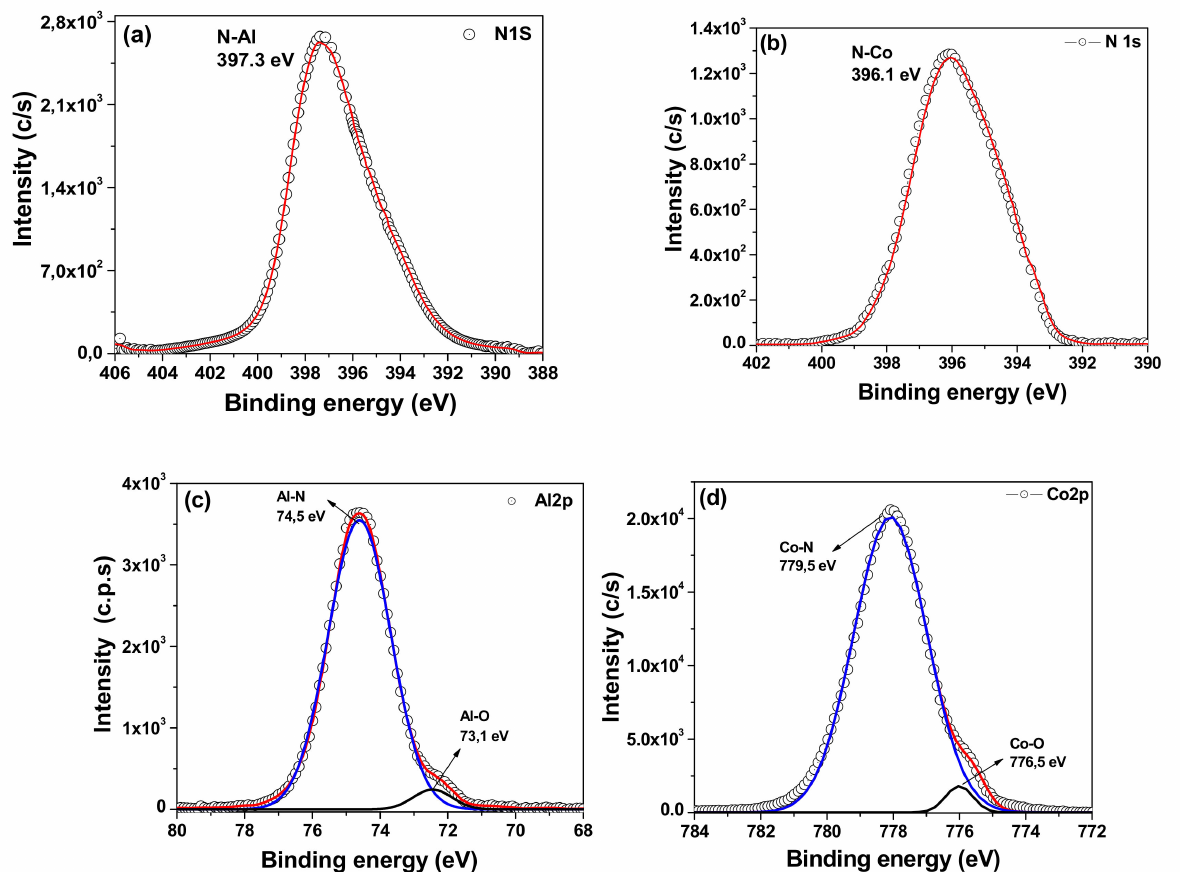
Figure 4. High resolution XPS spectra for AlN and CoN layers: ( a ) N1s signal in the (AlN) layer, ( b ) N1s signal in the (CoN) layer, ( c ) Al2p signal in the (AlN) layer and ( d) Co2p signal in the (CoN)